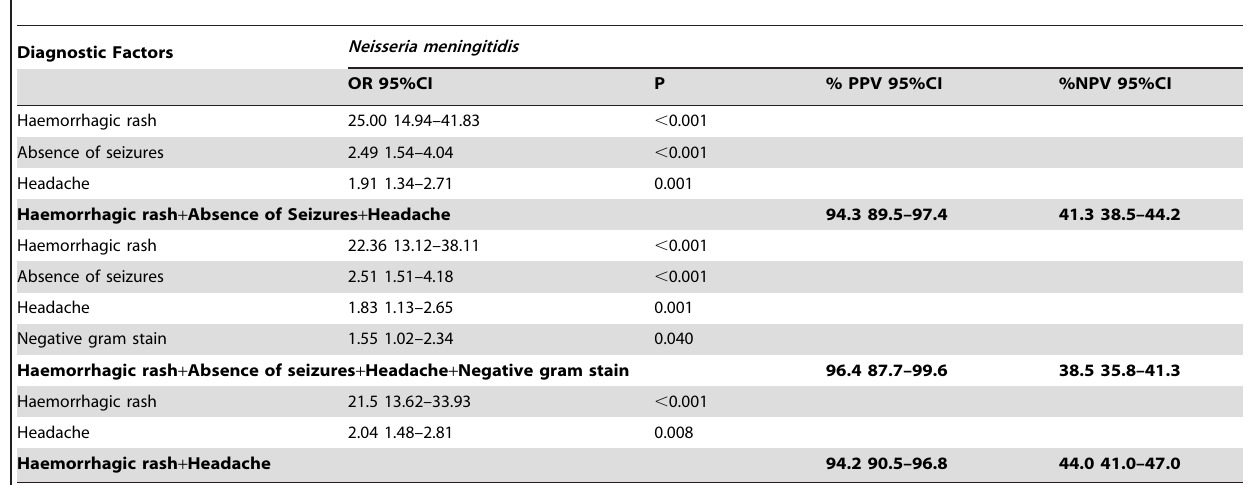
Table 6. Multivariate analysis of diagnostic factors for the diagnosis of Neisseria meningitidis